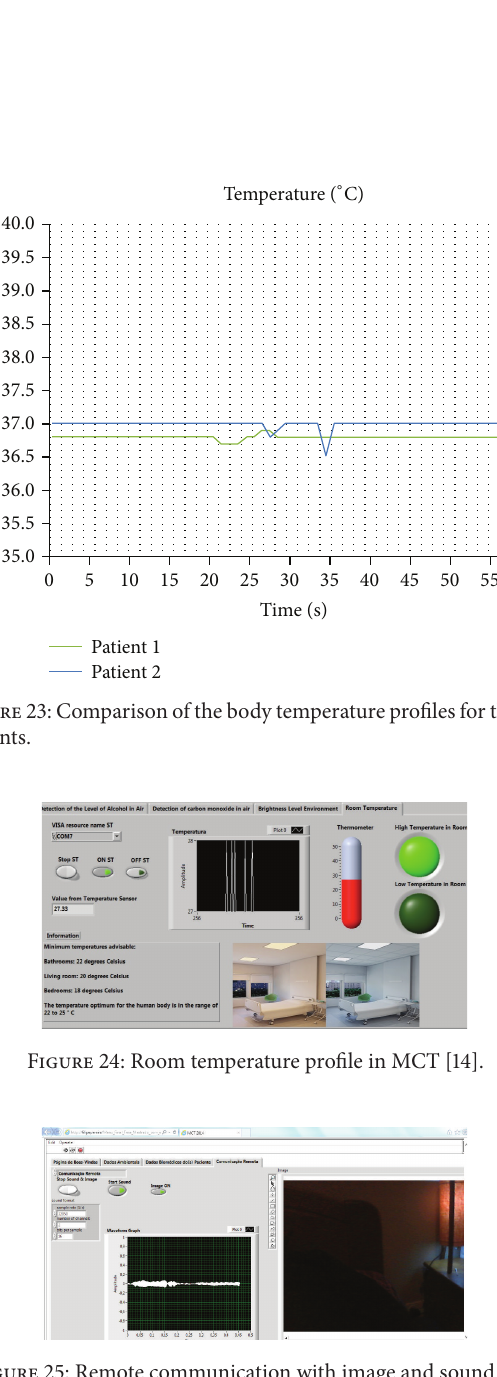
Figure 25: Remote communication with image and sound